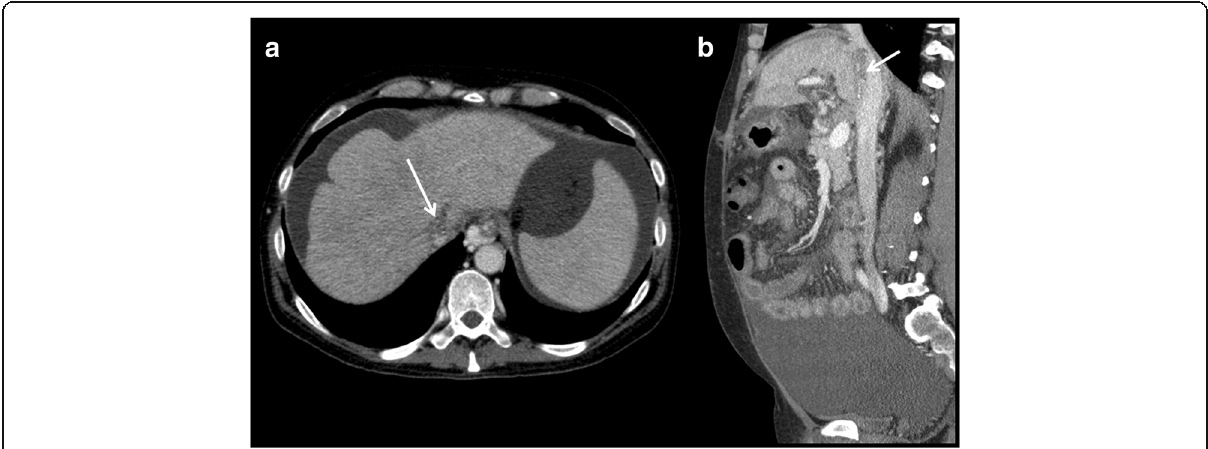
Fig. 13 a , b Stenosis of the inferior vena cava. Stenosis of the inferior vena cava is seen on the axial and sagittal images. It affects hepatic vein confluence. Difficulty with venous drainage produces ascites. Percutaneous angioplasty is performed for treatment